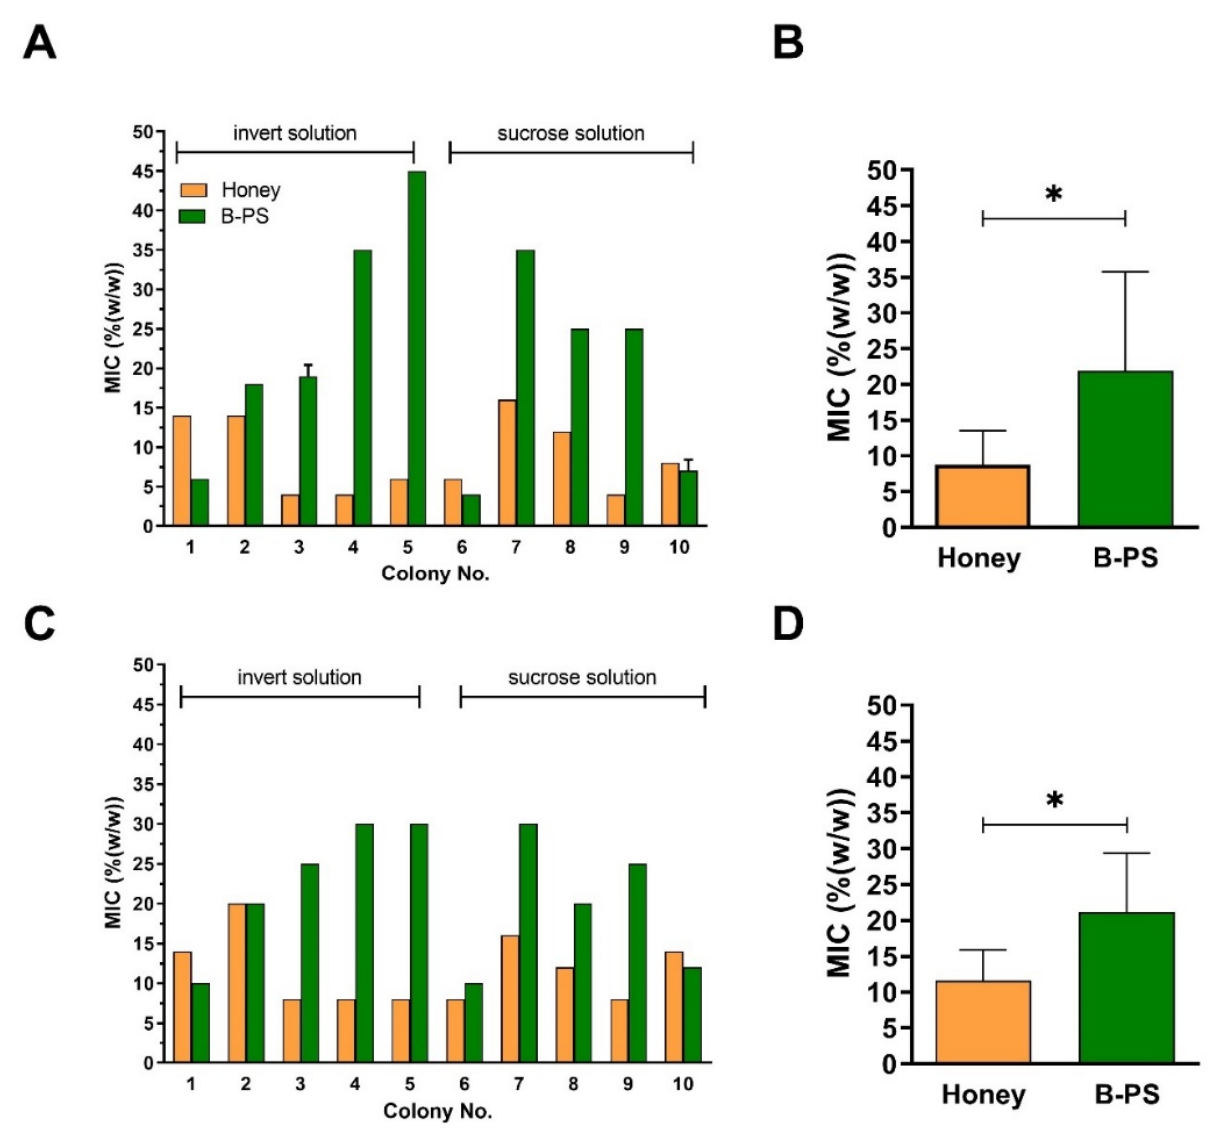
Figure 2. Antibacterial activities of raw honey samples and bee-processed syrups (B-PS) from bee colonies ( n = 10) against Staphylococcus aureus ( A , B ) and Pseudomonas aeruginosa ( C , D ) isolates. Honey and bee-processed syrups were subsequently collected from the same colonies. Activity was determined with a minimum inhibitory concentration (MIC) assay. ( B , D ) Average MIC values for honey samples and bee-processed syrups. Data are expressed as the mean values with SD. * p < 0.05 (Wilcoxon test).